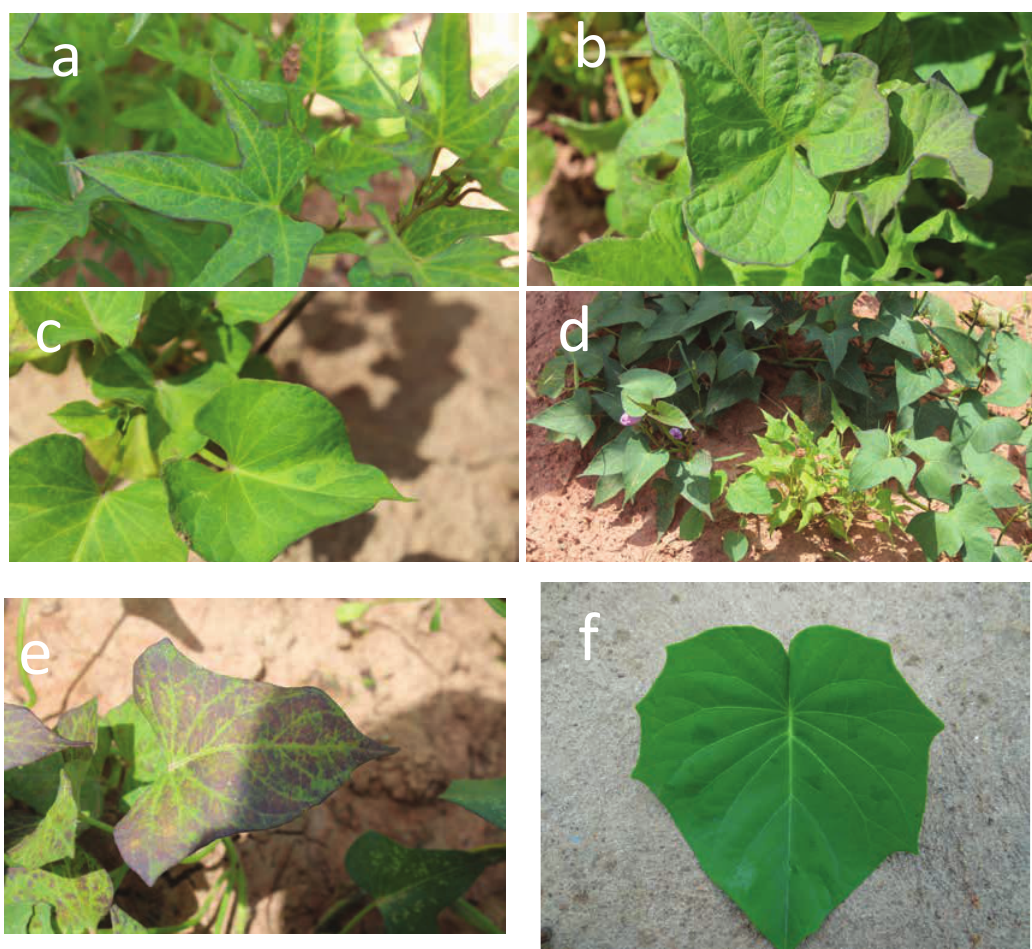
Figure 1: Leaf symptoms on sweet potato plants affected by viruses (a-c) Mild mosaic and vein-clearing. (d) Symptomless plant (extreme left) with severe stunting of growth (extreme right). (e) Purpling spot- ting in systemically infected leaves. (f) Healthy leaf.